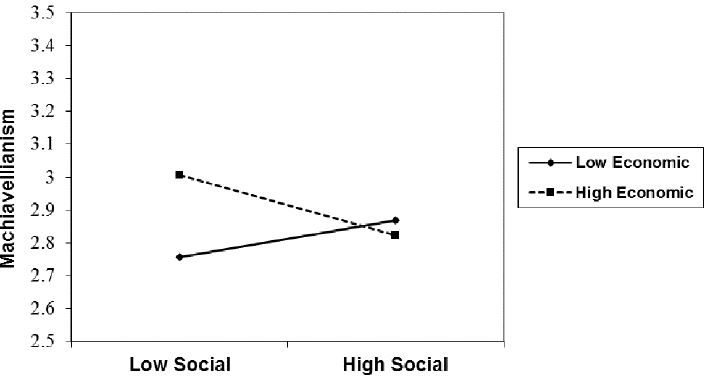
Figure 1. The Study 1 interaction between social and economic political ideology in relation to